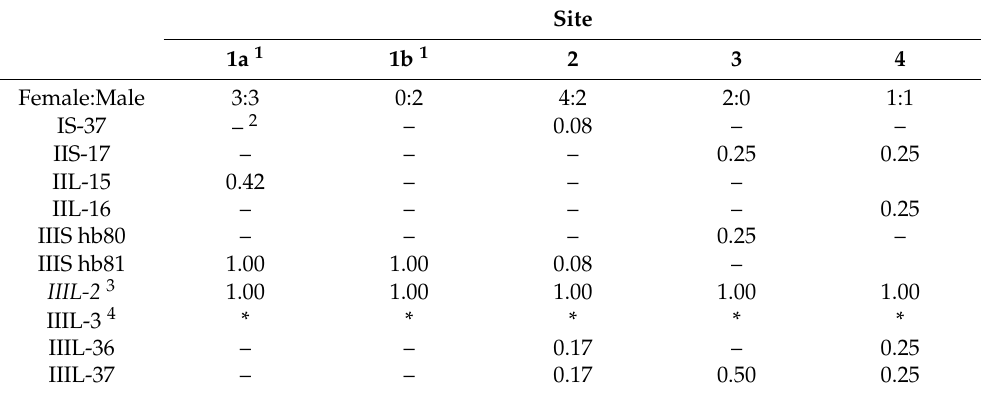
Table 2. Frequency of homologues with chromosomal rearrangements in larvae of Prosimulium supernum n. sp. from the Rocky Mountains of Colorado and